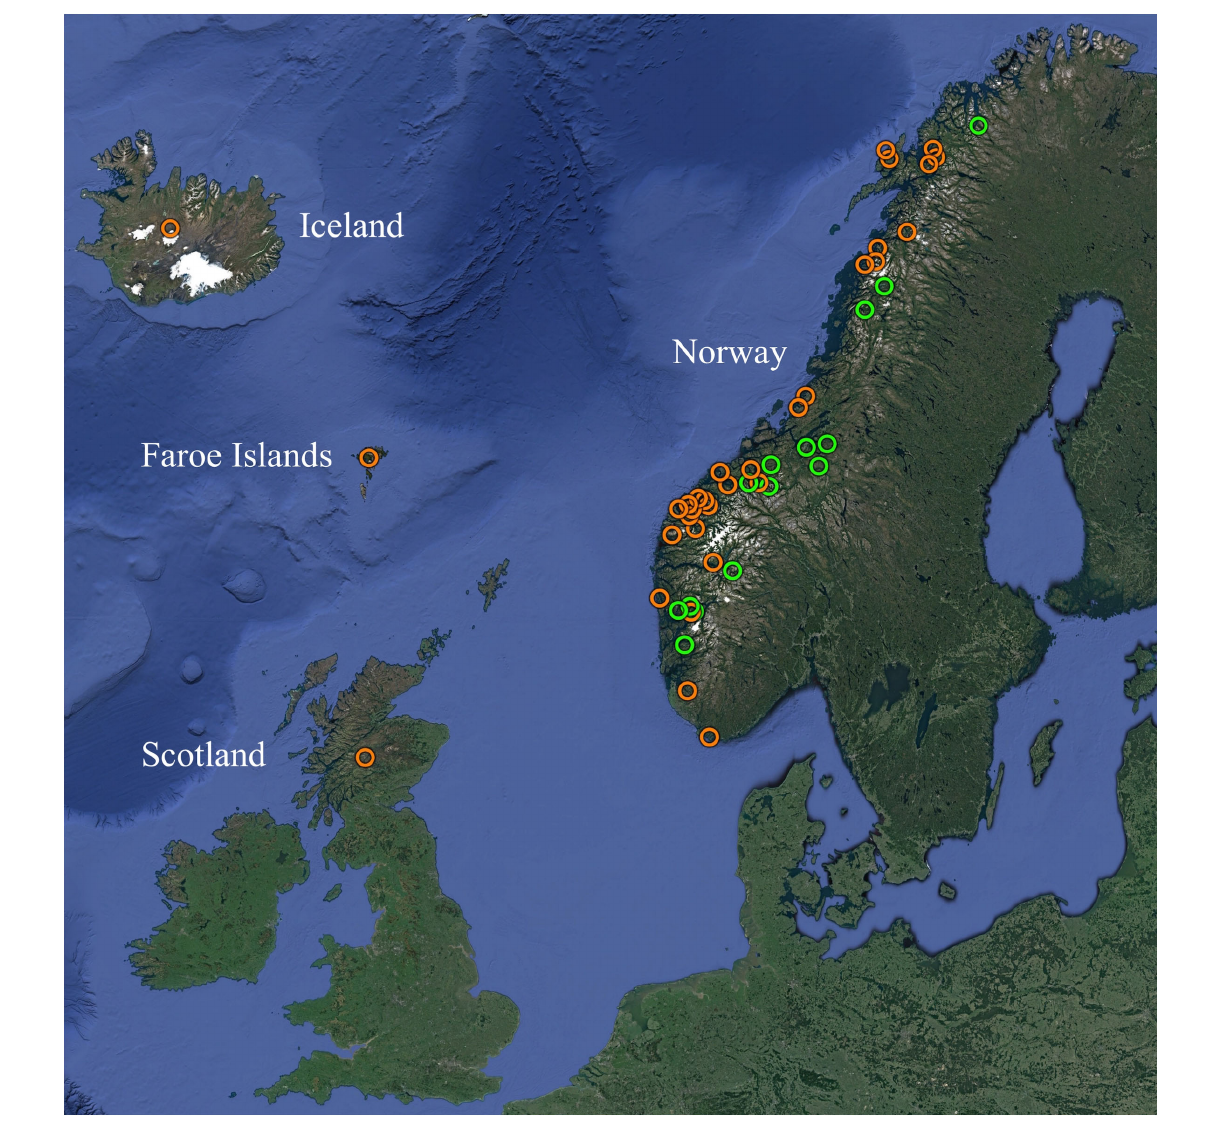
Frontiers in Microbiology |